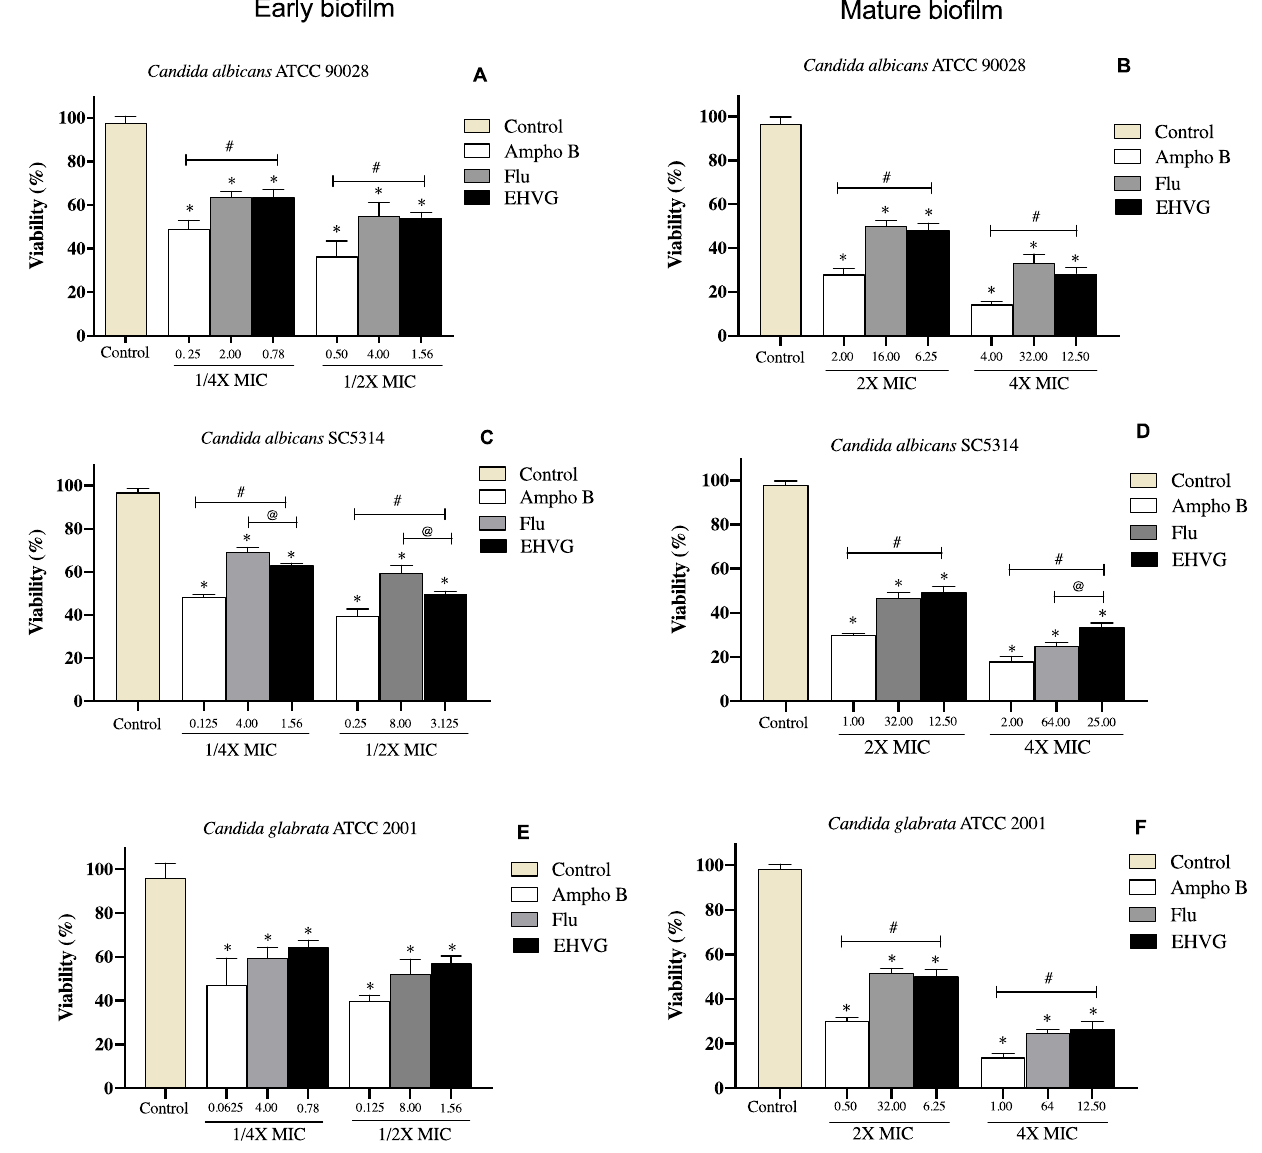
Figure 9. Percentage of inhibition on EHVG-treated early ( A , C , E ) and mature biofilms ( B , D , F ) of Candida albicans ATCC 90,028 ( A , B ), C. albicans SC5314 ( C , D ) and C. glabrata ATCC 2001 ( E , F ) after 48 and 72 h, evaluated by MTT assay. Samples were treated with EHVG (1/4 and 1/2 for early biofilms, and 2 × and 4 × MIC for mature biofilms) and compared to untreated controls or the reference drugs Amphotericin B (Ampho B) and Fluconazole (Flu). (*) p < 0.05 compared to control. (#) p < 0.05 compared to Amphotericin B and (@) p <0.05 compared to fluconazole.